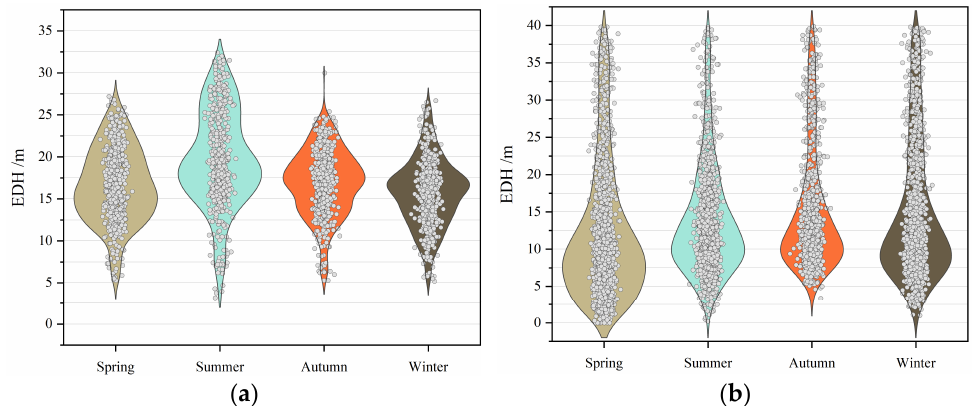
Figure 6. Distribution of the EDH in the Taiwan Strait in different periods and seasons during 2020: ( a ) statistical results from 9 to 14 o’clock; ( b ) statistical results in other periods.